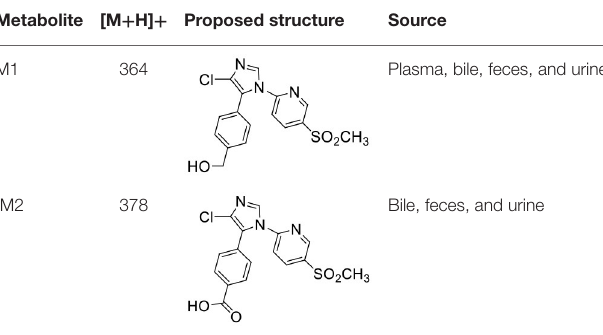
TABLE 2 | Structures of metabolites (M1 and M2) of vitacoxib in